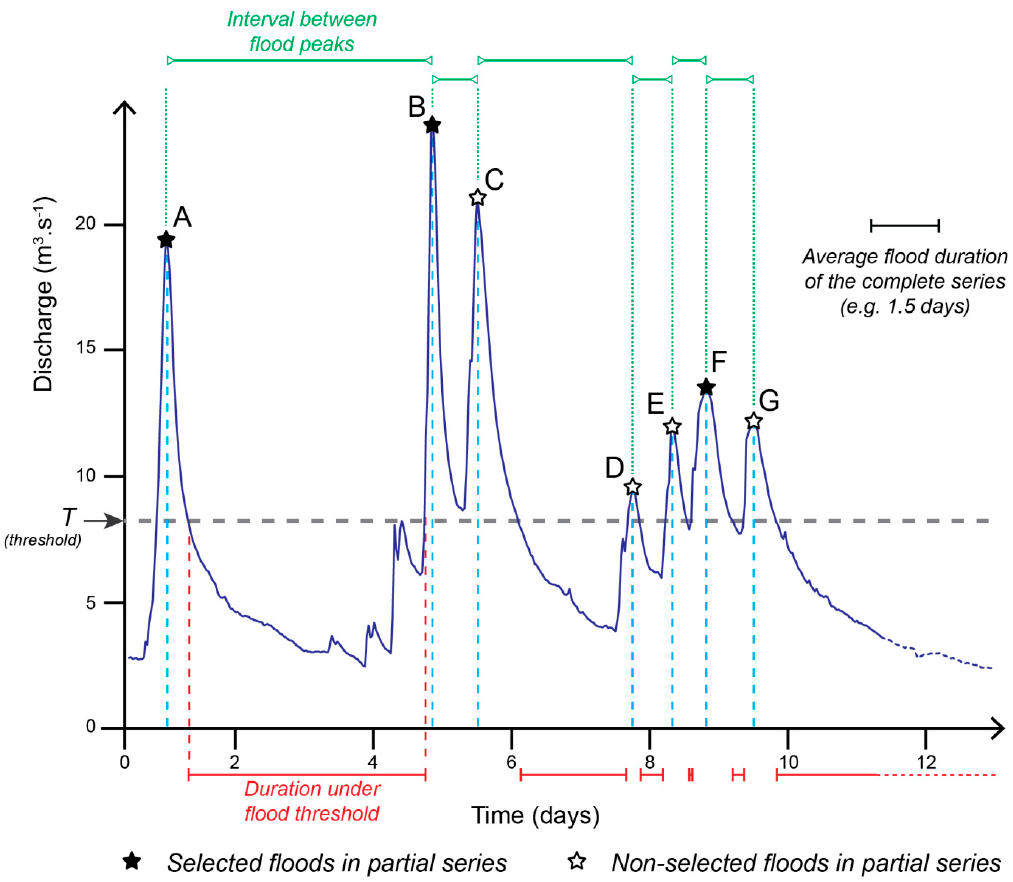
Figure 3. Principle of selection of peaks over threshold (POT) in partial series.